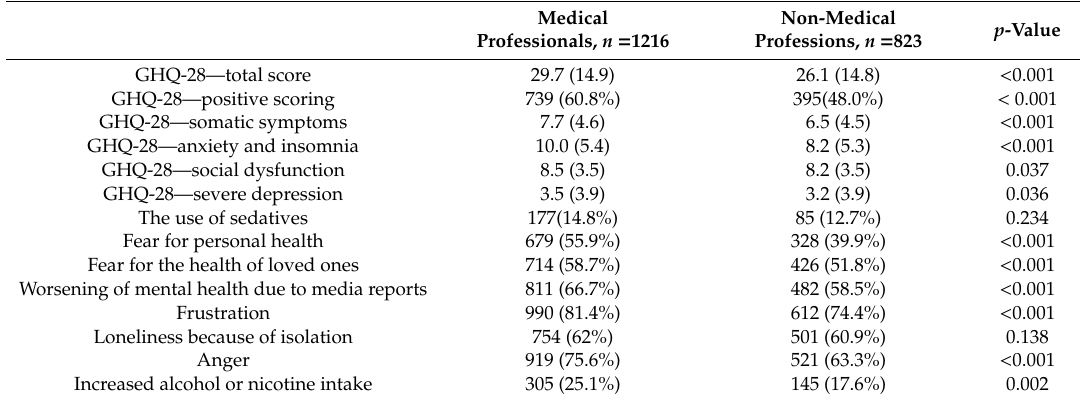
Table 2. Measures of psychopathology in medical professionals and individuals representing non-medical professions.